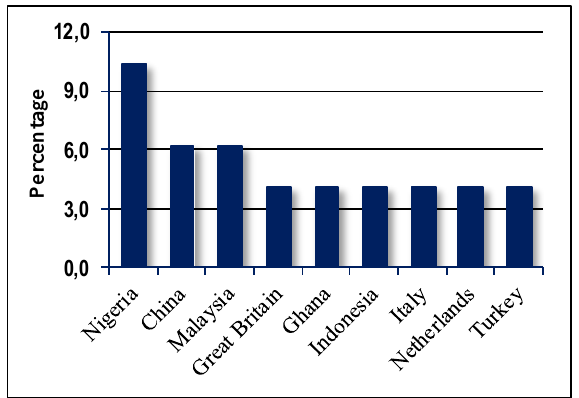
Figure 3. Countries making major contribution in implementation and research related to Web-GIS and GIS: mapping, GIS algorithms and techniques, maps and new trends